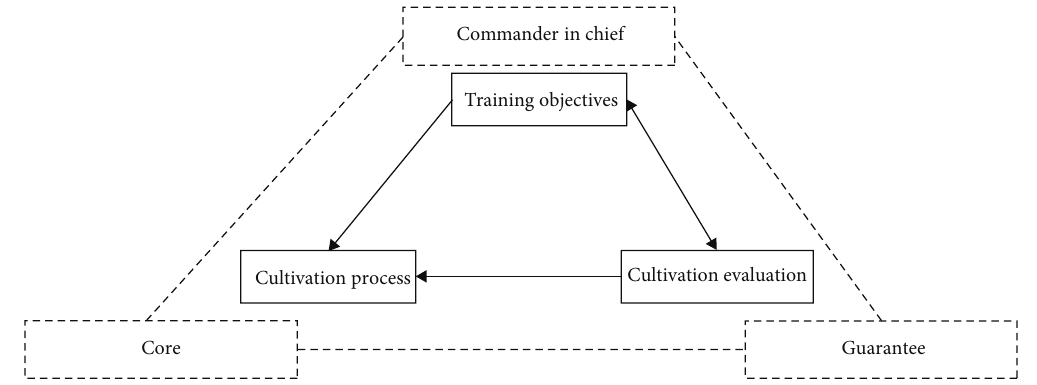
Figure 7: The role and relationship of the elements of the training model.